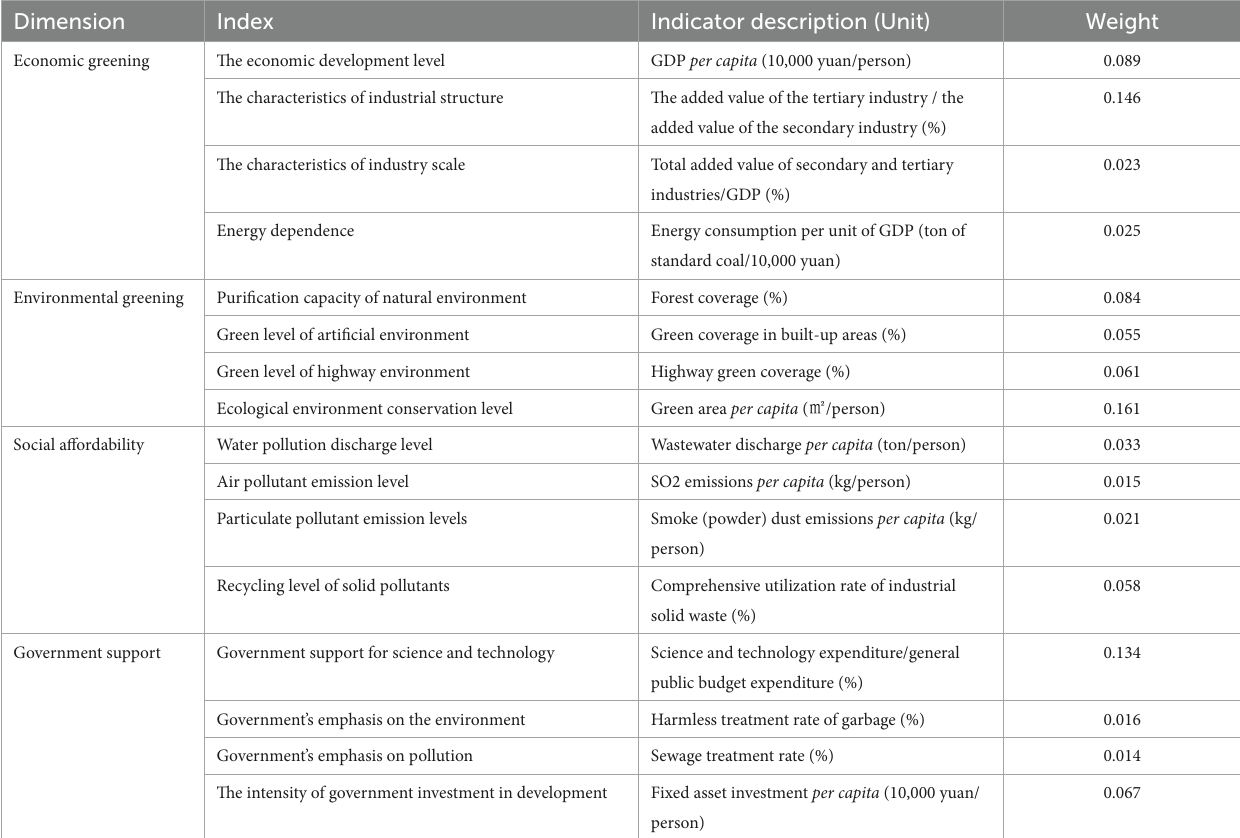
TABLE 2 Index system of urban greening